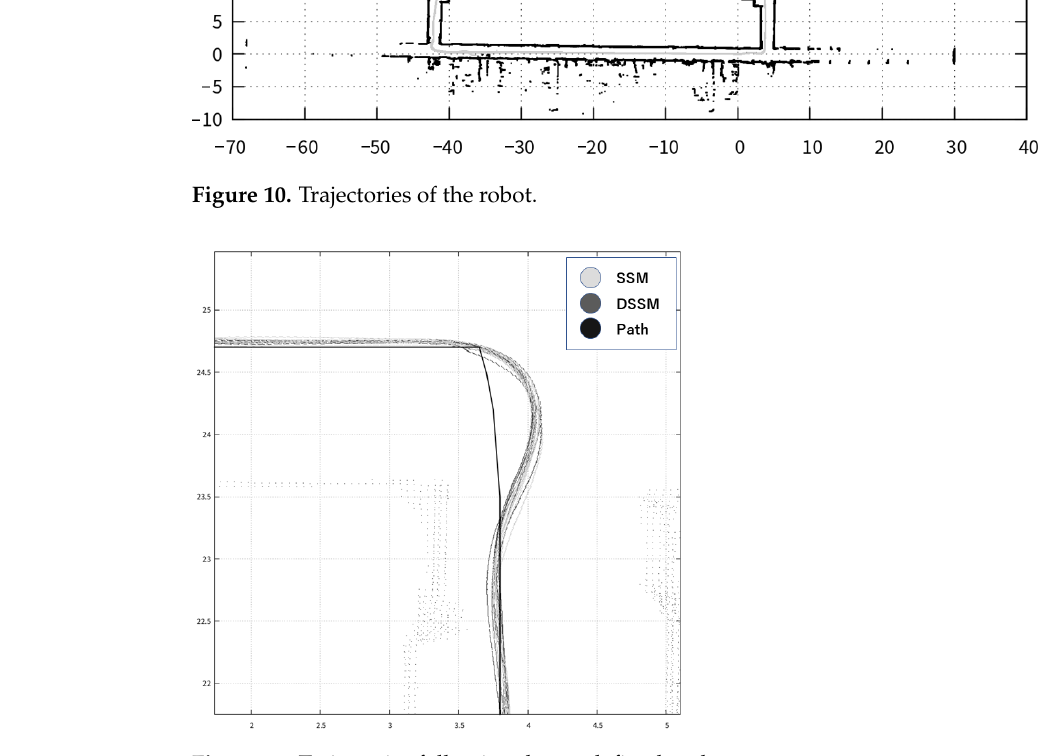
Figure 11. Trajectories following the predefined path.